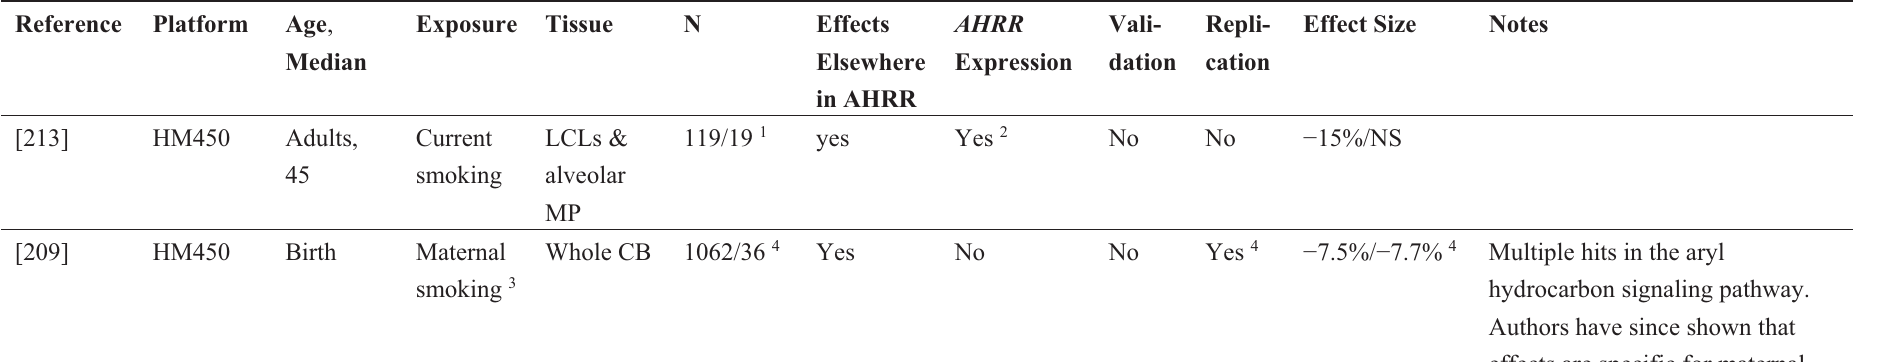
Table 3. Summary of findings for the relationship between smoking and DNA methylation within the AHRR gene. Data refer to AHRR HM450 probe cg05575921 unless otherwise stated. Summary includes details of assay platform, age of subjects, details of exposure, tissues examined, number of subjects, whether AHRR expression was also measured, whether findings were validated or replicated and effect size (methylation levels in smokers compared to